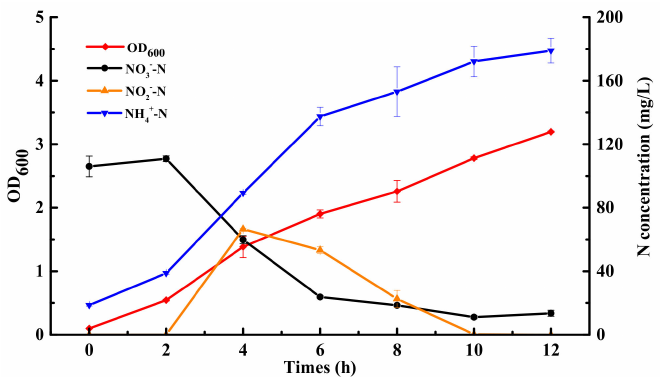
Figure 8. The nitrogen removal performance of the knock-out mutant strain JD-014 ∆ nirsir on